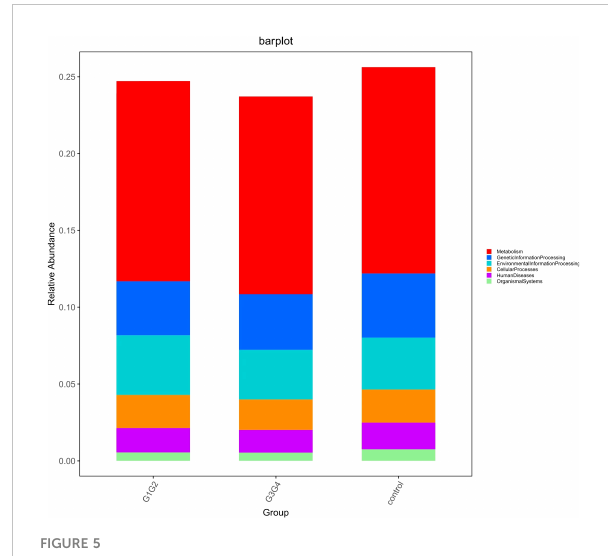
FIGURE 5 Barplot showing the composition of the top 6 functions in terms of maximum relative abundance at the KEGG level1.